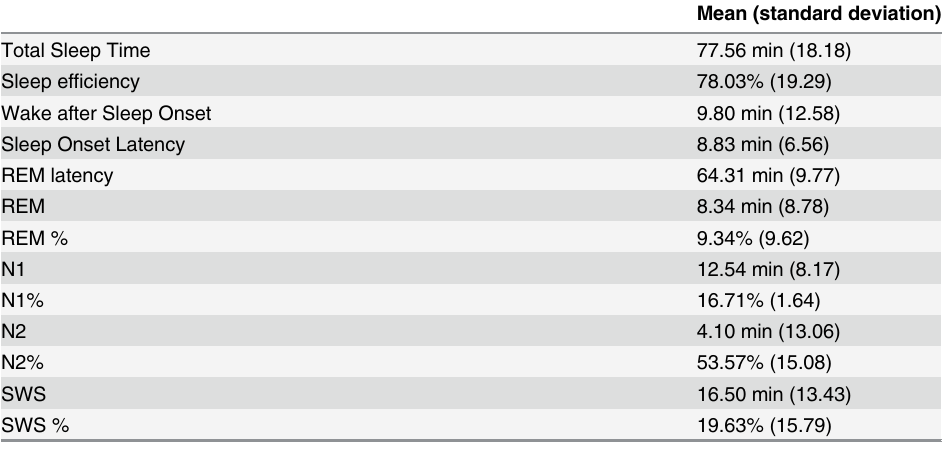
Table 5. Polysomnographic data of the